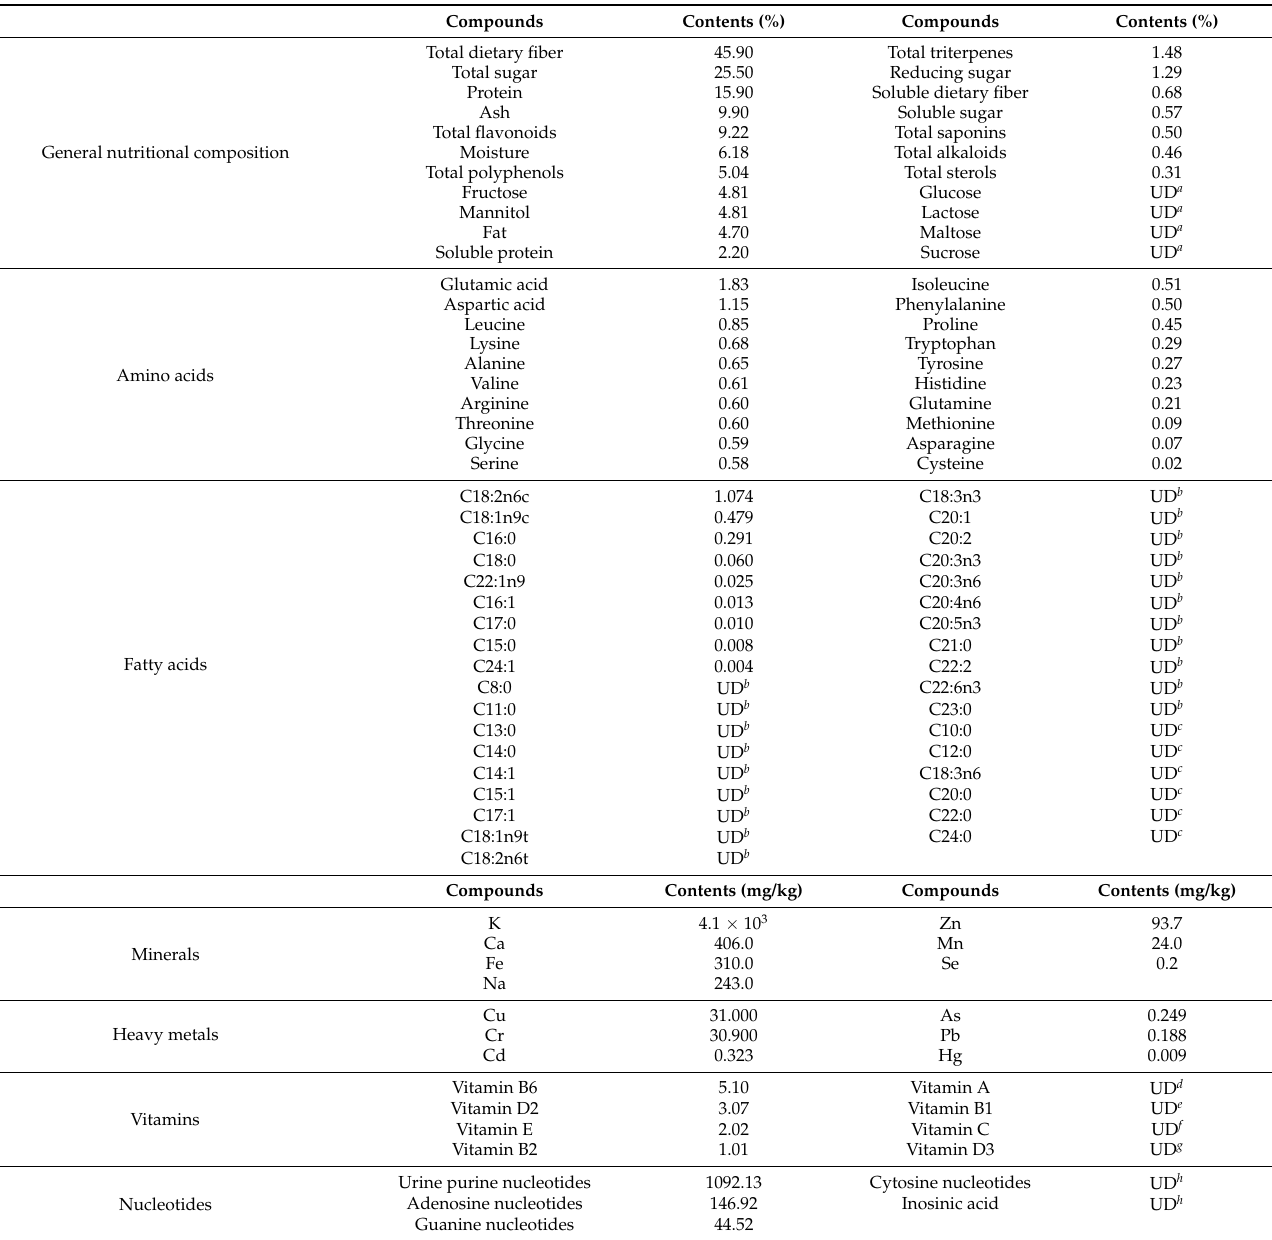
Table 1. The main composition of